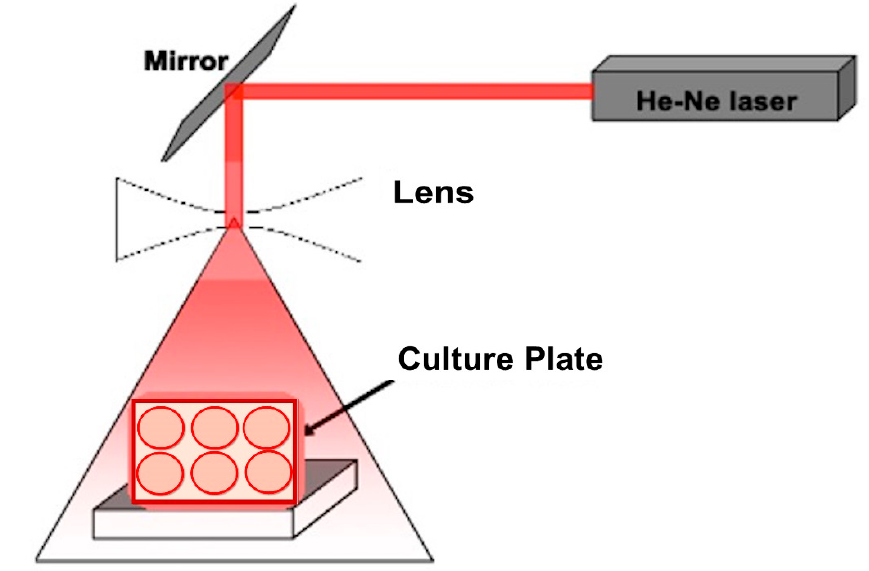
Figure 1. Experimental setup for culture exposure to red laser.